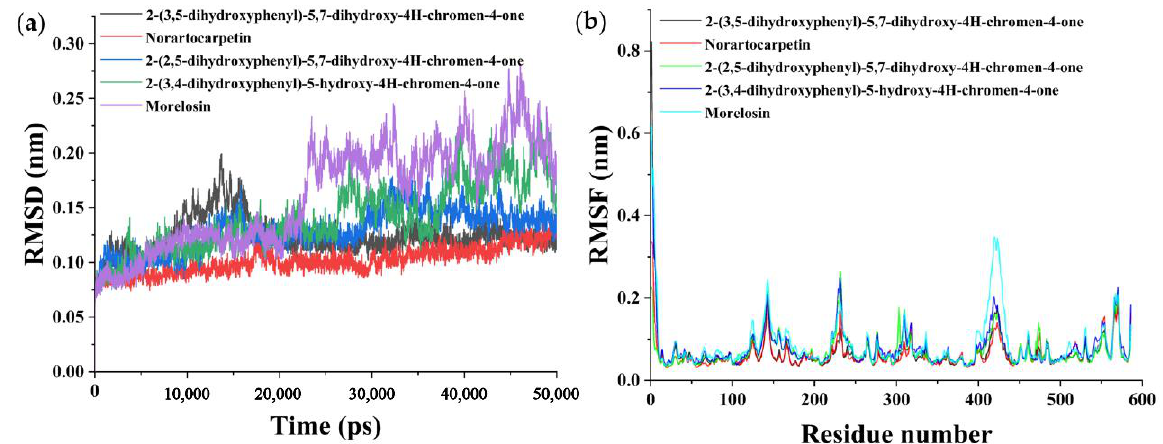
Figure 5. Molecular dynamics simulation (50 ns) results of five novel natural products complexed with α -glucosidase: ( a ) Root-mean-square deviation (RMSD, nm). ( b ) Root-mean-square fluctuation (RMSF, nm).